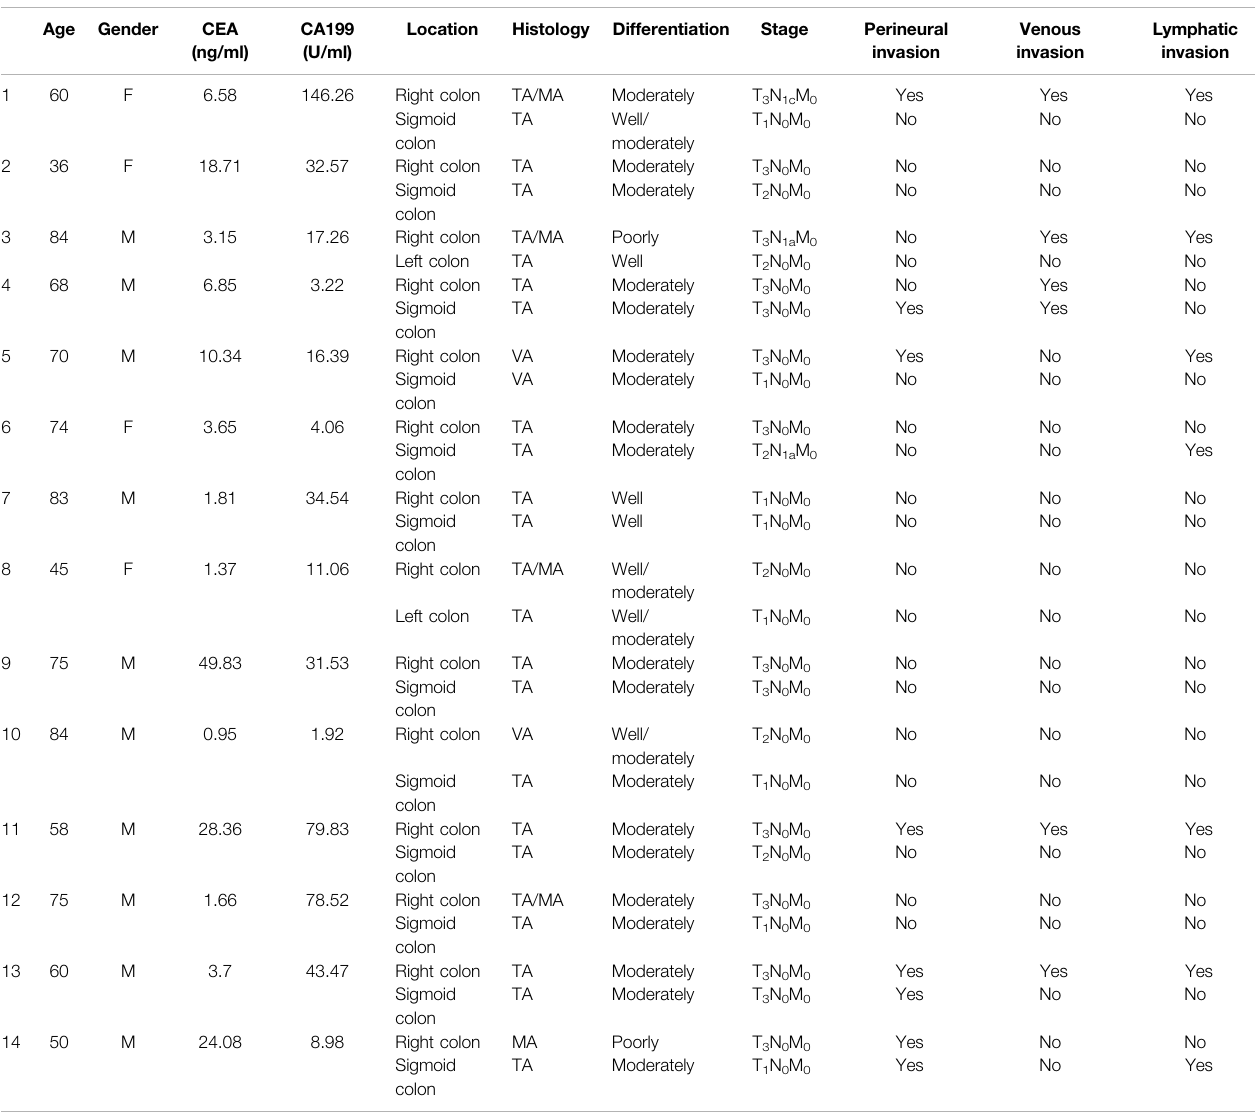
TABLE 1 | Demographic characteristic of the patients in our study. Age